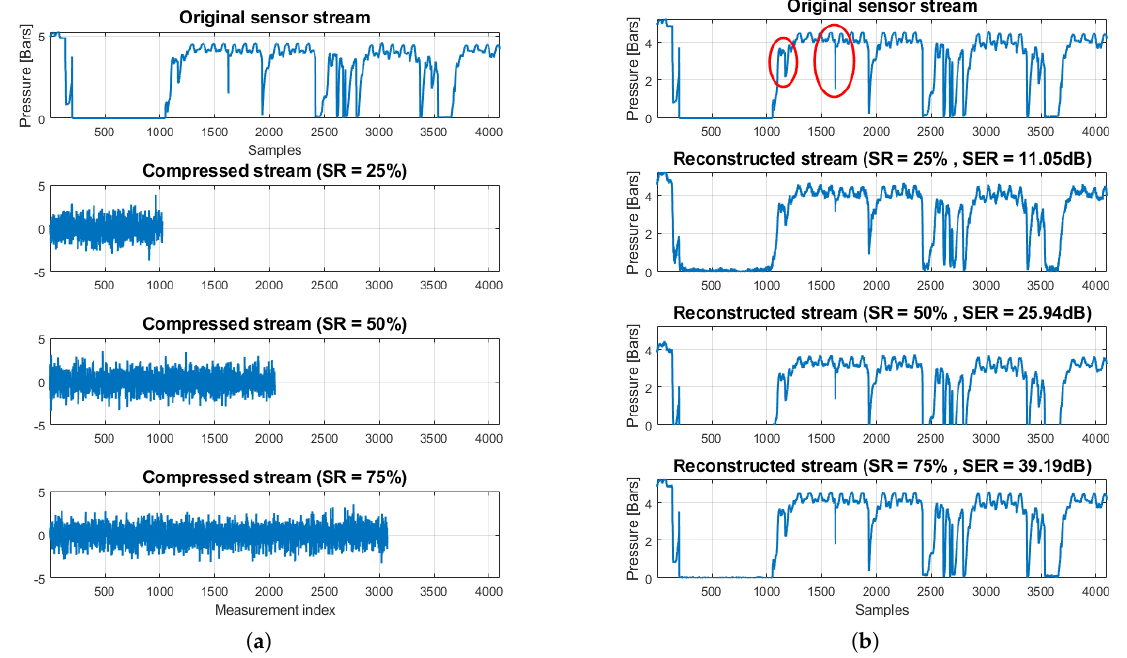
Figure 5. ( a ) Original stream under abnormal network conditions and its compressed versions; and ( b ) original stream and CS-based reconstructions, for three distinct sampling ratios SR ∈ { 25%,50%,75% }